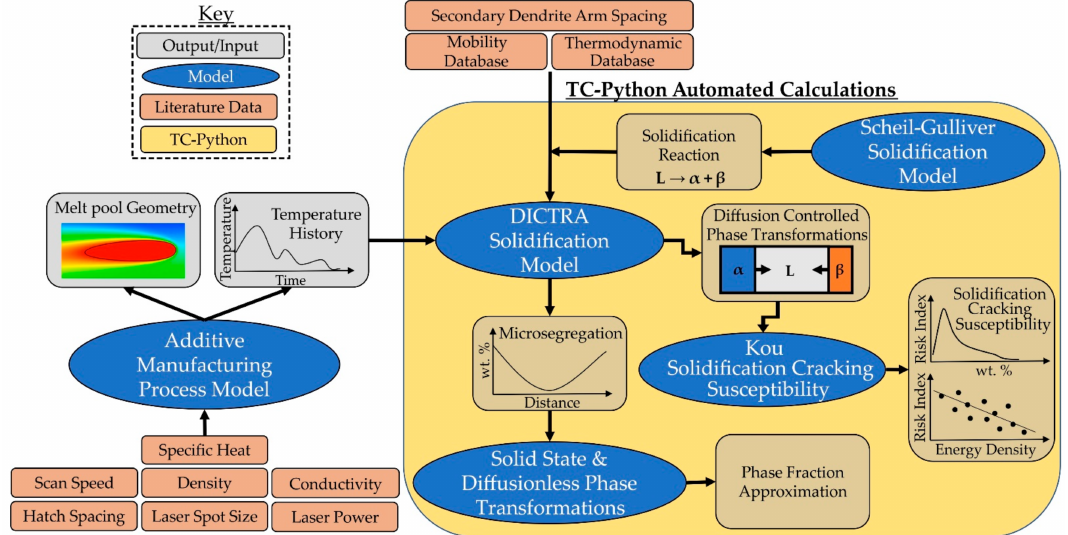
Figure 1. CALPHAD-based ICME (CALPHAD: Calculation of Phase Diagrams, ICME: Integrated Computational Materials Engineering) framework for modeling non-equilibrium solidification of additively manufactured materials. This modeling framework integrates processing and microstructure models for non-equilibrium